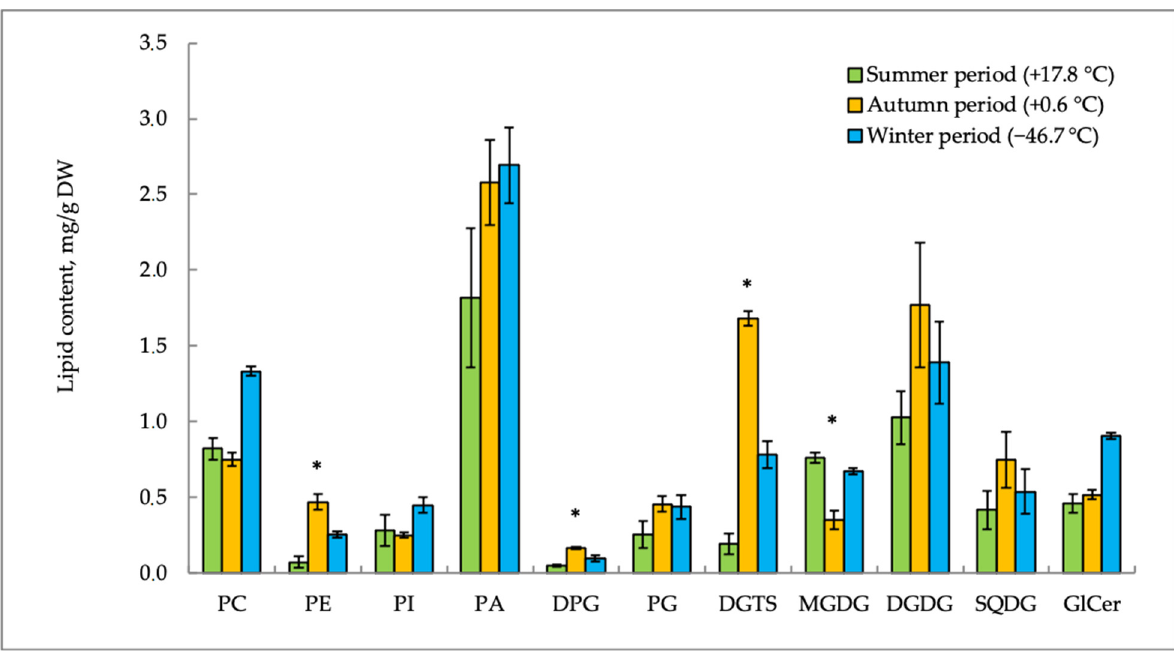
Figure 2. Seasonal changes in the content of individual lipid classes in E. variegatum shoots. PC—phosphatidylcholine; PI—phosphatidylinositol; PE—phosphatidylethanolamine; PG—phosphatidylglycerol; PA—phosphatidic acid; DPG— diphosphatidylglycerol; GlCer—glycoceramide, DGDG—digalactosyldiglyceride, DGTS— O -(1,2-diacylglycero)- N , N , N - trimethylhomoserine, MGDG—monogalactosyldiglyceride, SQDG—sulfoquinovosyldiacylglycerol. Data are shown as the mean ± SD ( n = 3); * significant differences according to Student’s t -test.